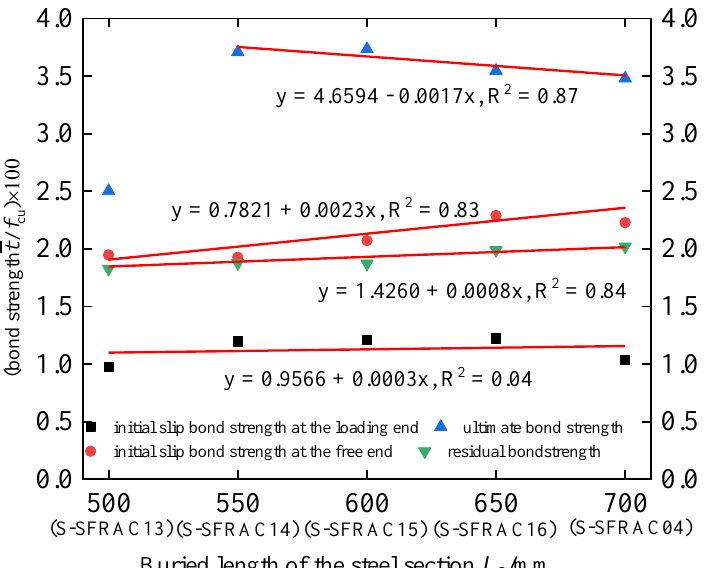
Figure 19. Relationship between bond strength and embedded length of section steel.